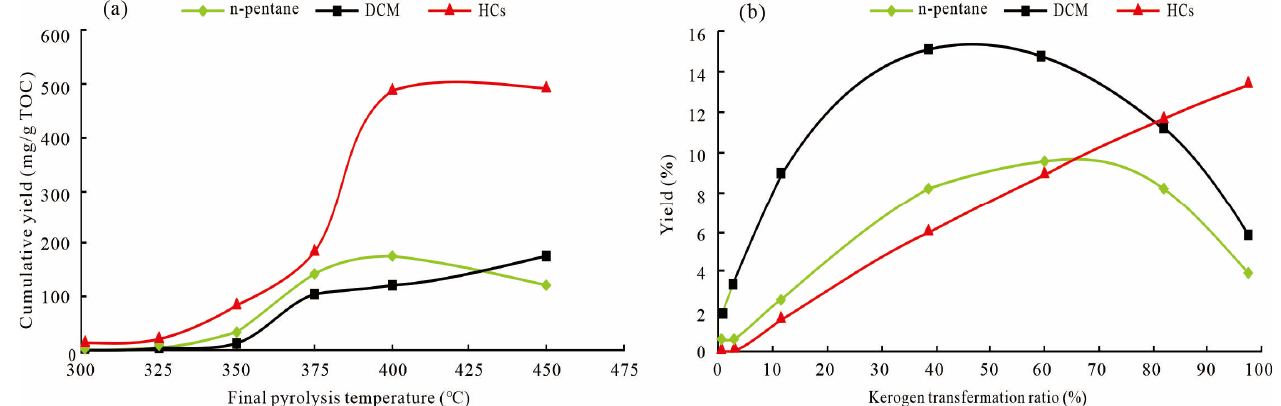
Figure 12. Changes for HCs, n –pentane, and DCM NSOs of Lucaogou Formation shale ( a ) and Toarcian shale ( b ). The yield of Lucaogou Formation is reported as mg/g TOC (48 h duration), while the yield of Toarcian shale is presented as the mass fraction by weight of raw rock (72 h duration).